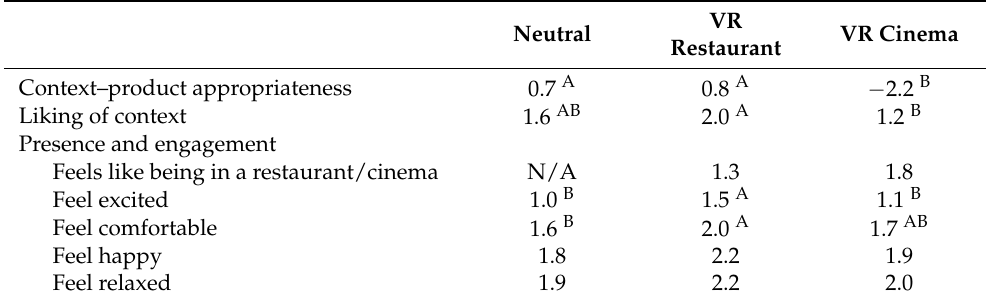
Table 1. Comparison of context–product appropriateness and participants’ presence sensation and engagement between contexts (n = 70).